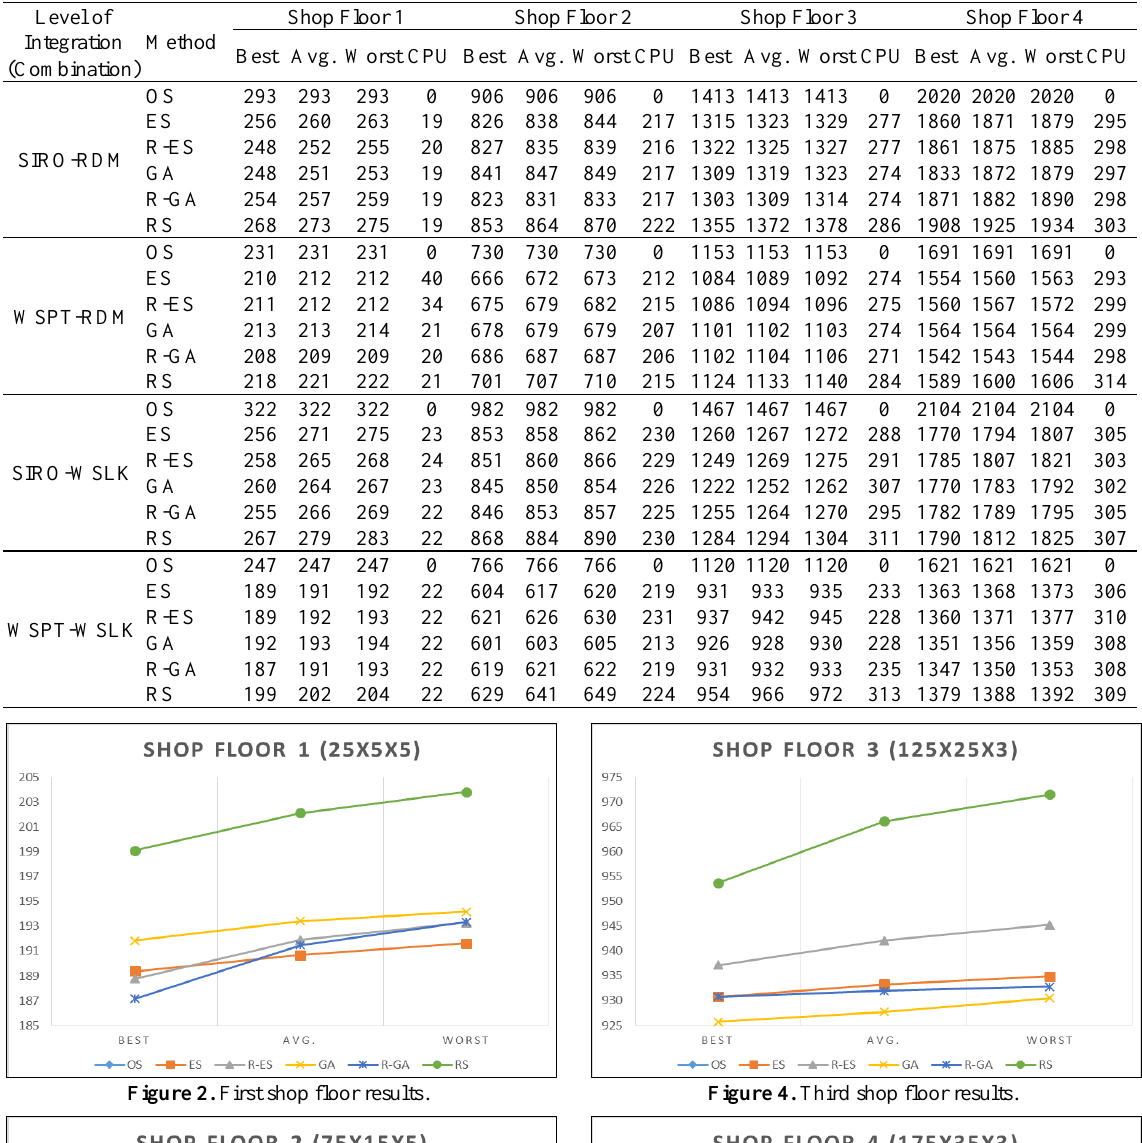
Table 5. Comparison of twenty-four solutions for each shop floor.